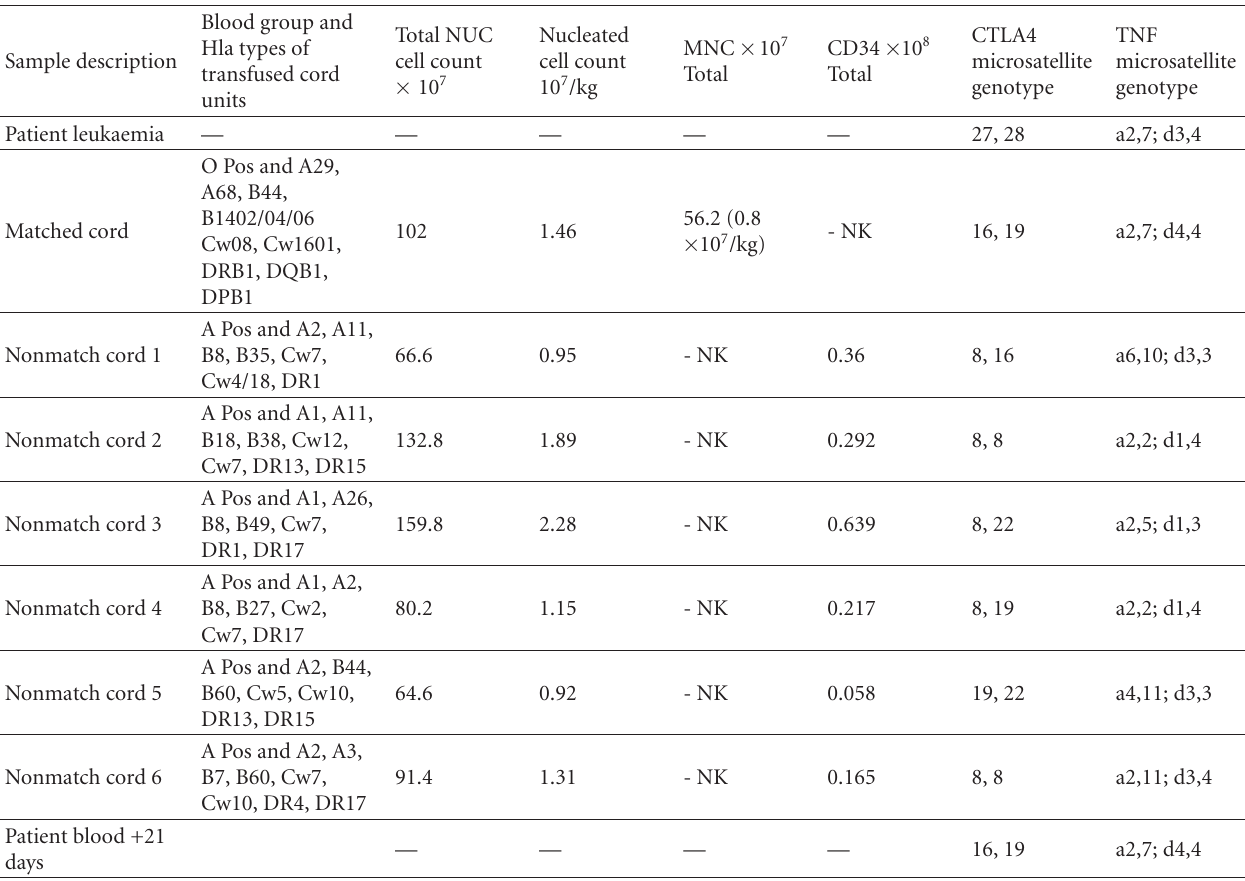
Table 1: Details of transplanted cord units. Cellular characteristics and HlA types of the cord units used in the transplant are given. No attempt was made to have matching tissue types in the unmatched cords. The matched cord di ff ered from the patient in blood group Patient A+ matched cord O+. Tissue type of matched cord was identical at Class 1 DR, and DP were fully matched but there was a DQ mismatch. All cord donations were female and CMV antibody negative Genotypes are the allele ID’s for the markers used at the CTLA4 and TNFA loci (refs). The matched cord cell dose was substantially less than the recommended dose for engrafting an adult ( 0 . 8 × 10 7 /kg) but engraftment of granulocytes was swift and uncomplicated. NK-not known.